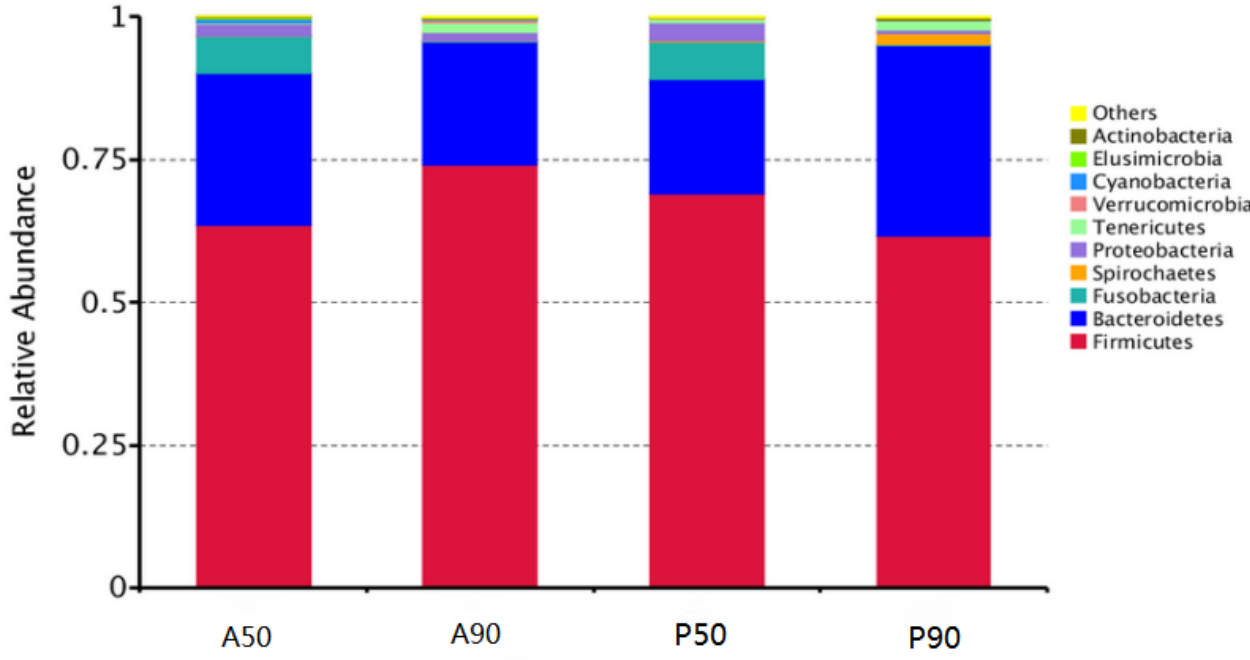
Figure 1. Average relative abundance of microorganisms at the phylum level in the feces of calves fed pasteurized milk (PM) and acidified milk (AM) ad libitum. A50, feces samples of calves fed AM on day 50; A90, feces samples of calves fed AM on day 90; P50, feces samples of calves fed PM on day 50; P90, feces samples of calves fed PM on day